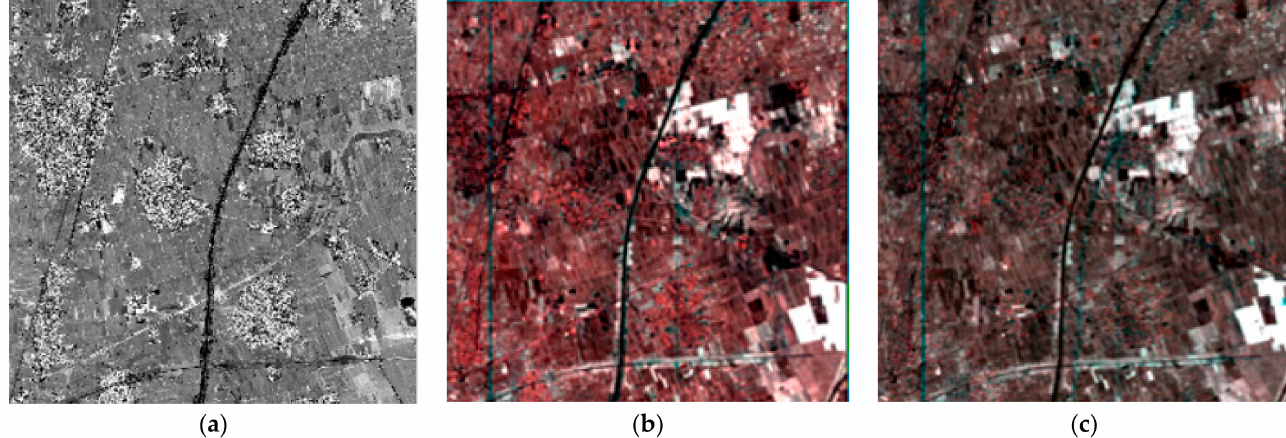
Figure 3. The Baiyangdian dataset: ( a ) Panchromatic image, ( b ) RGB image of hyperspectral data and ( c ) RGB image of ground truth